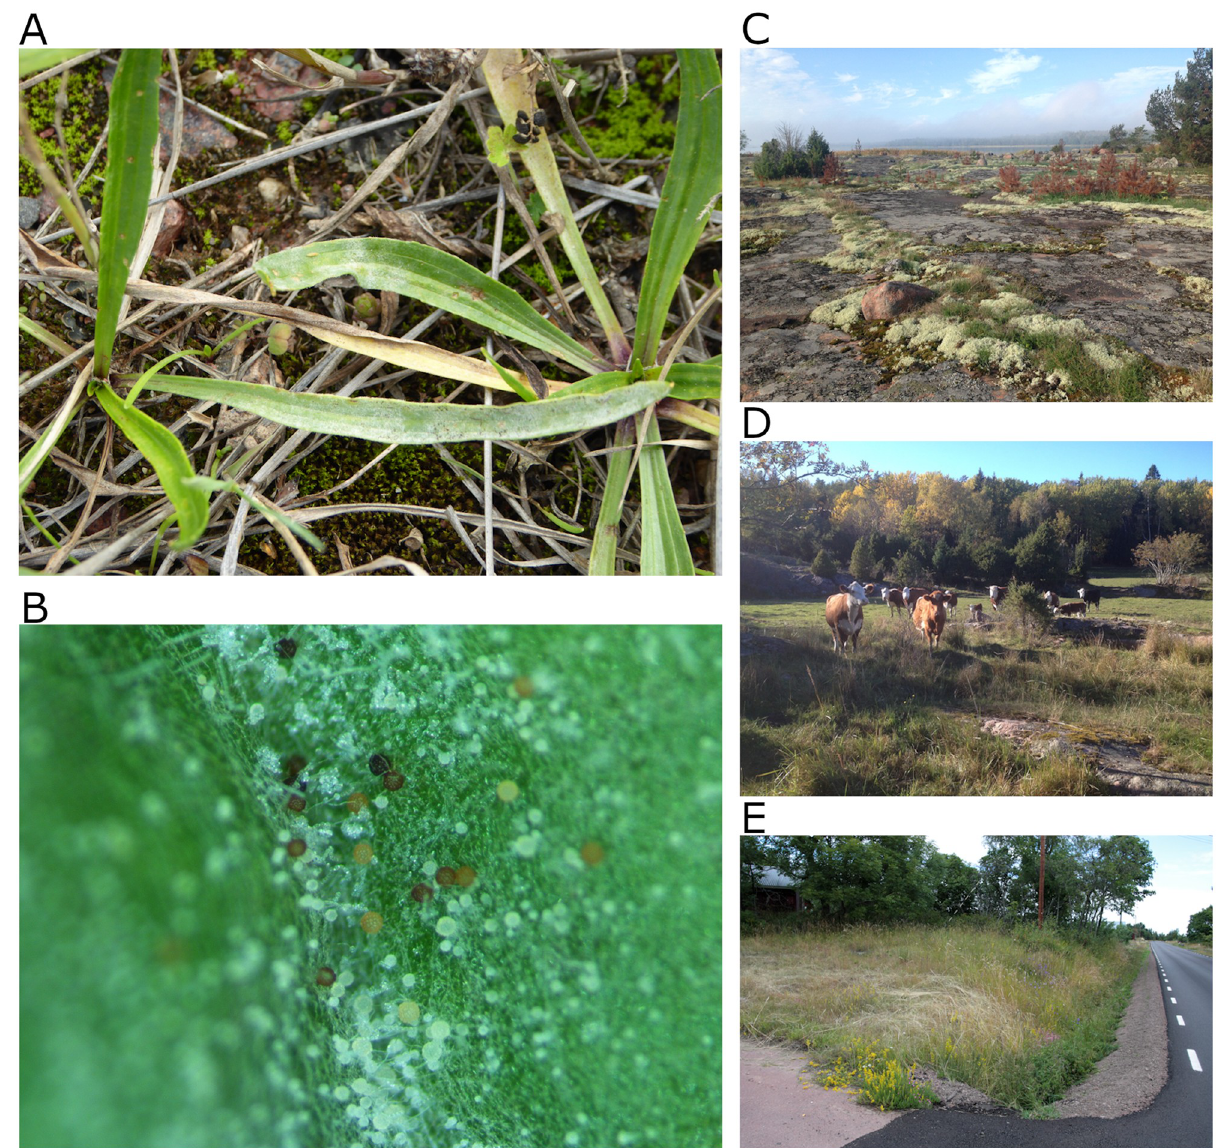
Fig 1. Panel A shows the powdery mildew infection on P. lanceolata , with a zoom-in in panel B, depicting both the clonal conidial spores that spread during the summer, and the larger and mainly darker spore structures, chasmothecia, that ensure the pathogen overwintering. Panels C-E depict example locations where the host grows in Å land